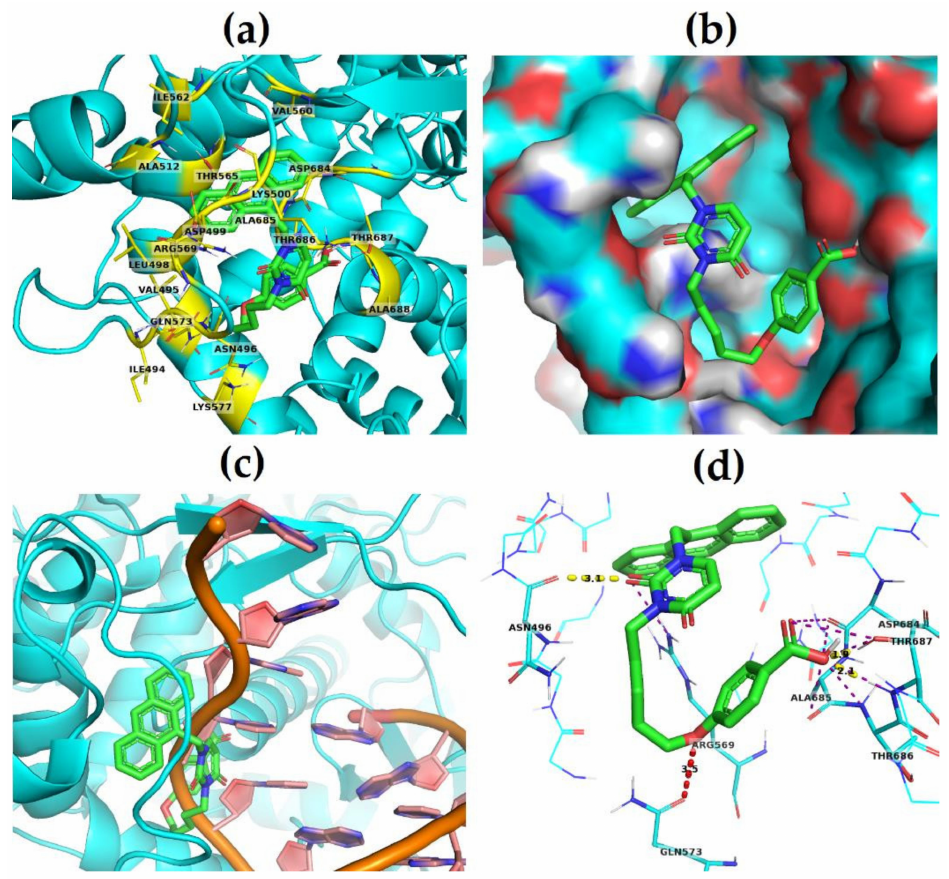
Figure 5. 876 Docked to NSP12. Receptor shown as cyan, ligand as green. ( a ) neighbouring amino acids (yellow), ( b ) pocket surface, ( c ) superposition of original 7EIZ with RNA duplex (brown), ( d ) polar contacts formed by 876 with NSP12 (yellow for H-bonds, red for electrostatic clashes, purple for